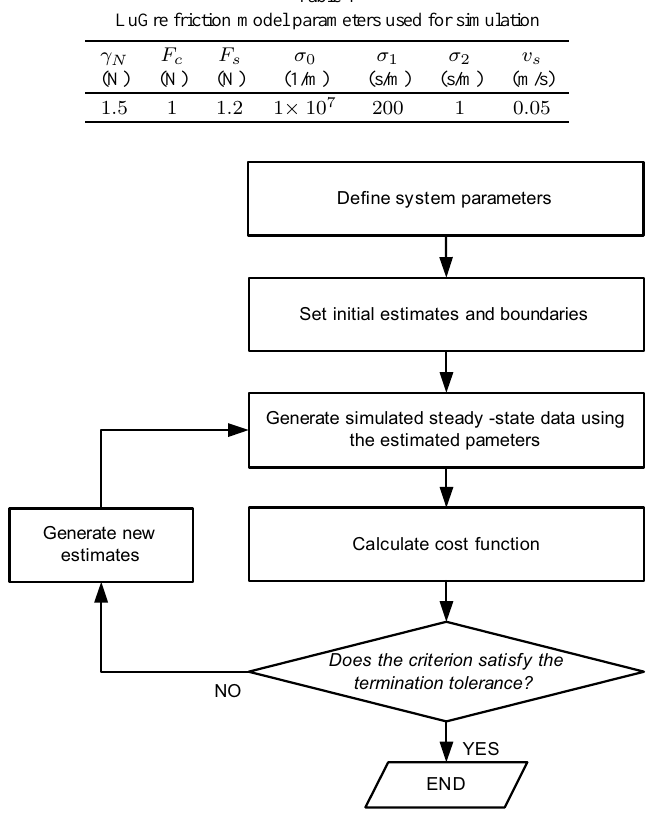
Fig. 3. Optimization-based algorithm for the identification of the LuGre friction model static